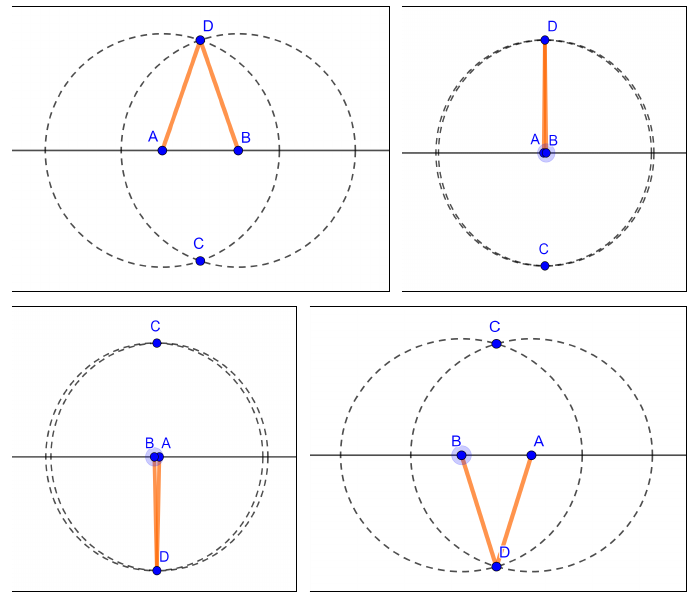
Figure 12. Continuity problems in DGS